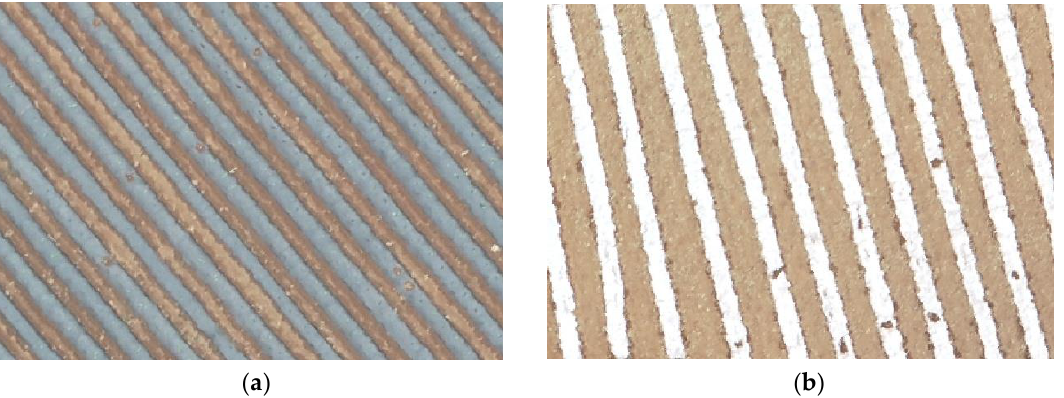
Figure 3. Flue-cured tobacco mulched with black film ( a ) and spring maize mulched with white film ( b ).